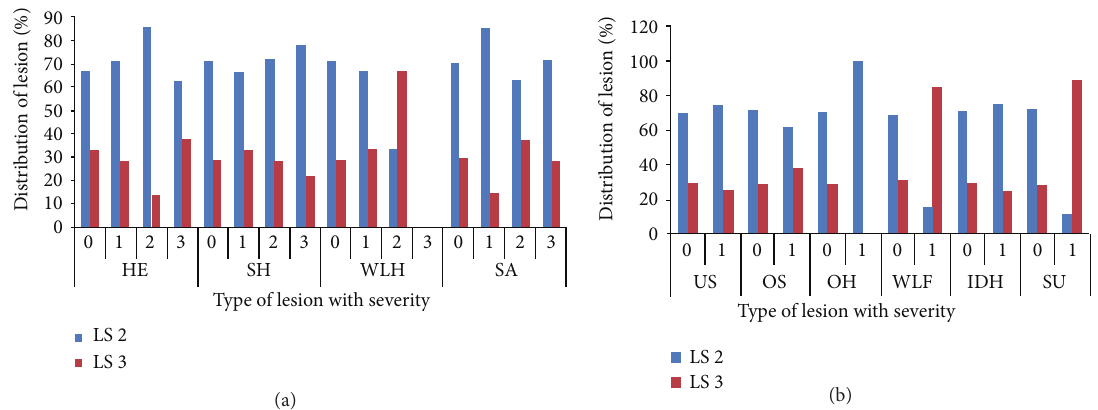
Figure 11: (a) Distribution of severities of lesions in cows with locomotion score 2 and 3, HE: heel erosion, SH: sole haemorrhage, WLH: white line haemorrhage, SA: sole avulsion, LS: locomotion score. (b) Distribution of severities of lesions in cows with locomotion score 2 and 3, US: under run sole, OS: overgrown sole, OH: overgrown hoof, WLF: white line fissure, IDH: interdigital hyperplasia, SU: Sole ulcer, LS: locomotion score.